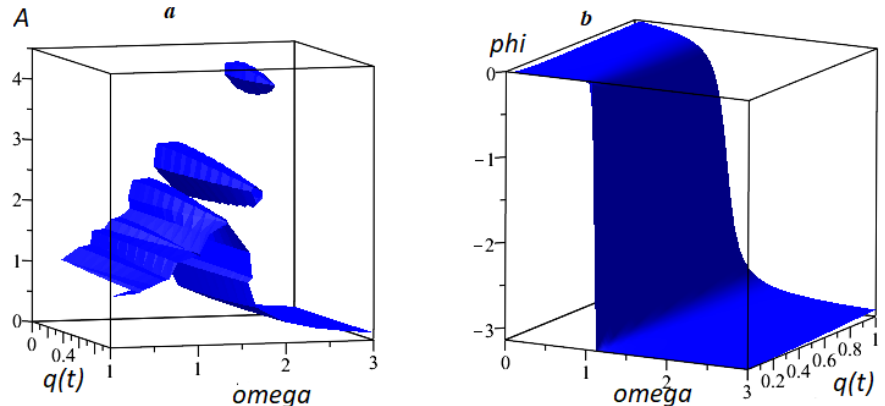
Figure 5. ( a ) AFC and ( b ) PFC with A = 1.5, t ∈ [ 96.4,97.5 ] , q ( t ) = sin 2 ( ω t )